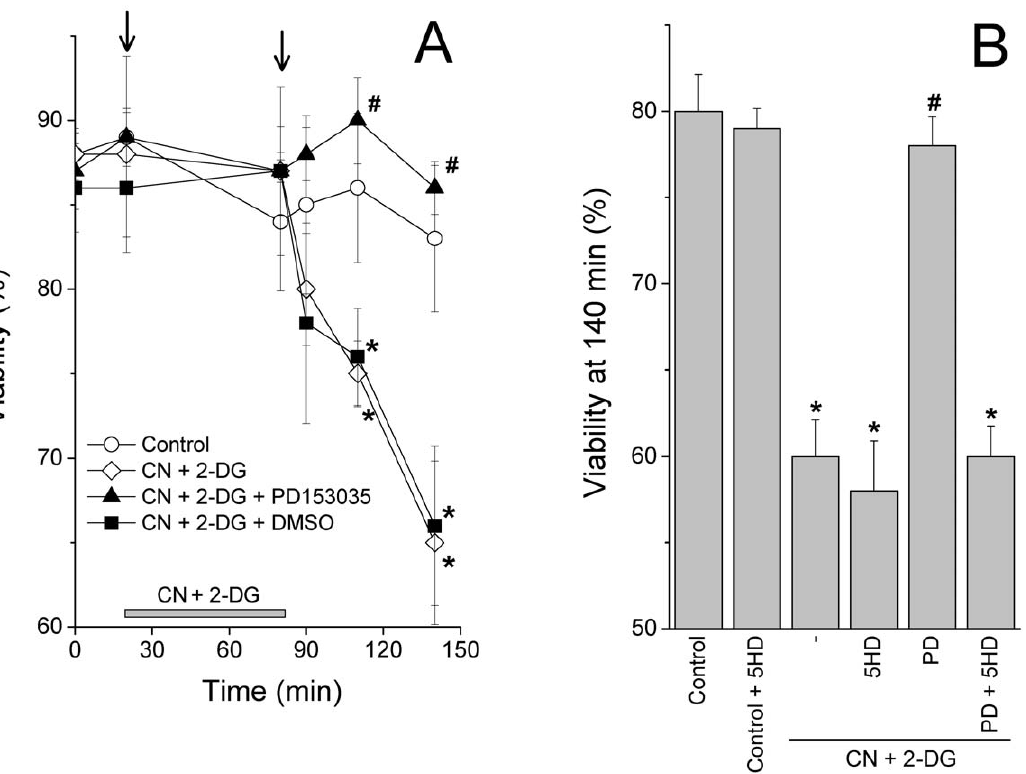
Figure 2. PD153035 protects against cardiac cell damage promoted by cyanide/aglycemia. Panel A : Cardiac HL-1 cells were preincubated in standard media (see Materials and Methods) containing 10 nM PD153035 ( m ), the equivalent concentration of PD153035 solvent DMSO (0.05%; & ) or no further additions ( # , e ). Where indicated, all cells except controls ( # ) were treated with 10 mM K-cyanide (CN) and 2 mM 2- deoxyglucose (2-DG). All cells were submitted to equal centrifugations and media changes where indicated by the arrows. Panel B represents average cellular viability at 140 min. HL-1 cells were treated as described in Panel A. Where indicated, cells were preincubated in the presence of 60 m M 5-hydroxydecanoate (5HD) and/or 10 nM PD153035 (PD). Data represent average cell viability (see Materials and Methods) of 5 experiments 6 SEM. Data in Panels A and B represent separate experimental groups in which baseline measurements are not significantly distinct. * p , 0.05 relative to ‘‘control’’ and ‘‘CN + 2-DG + PD153035’’ at the respective time point. # p , 0.05 relative to ‘‘CN + 2-DG’’ at the respective time